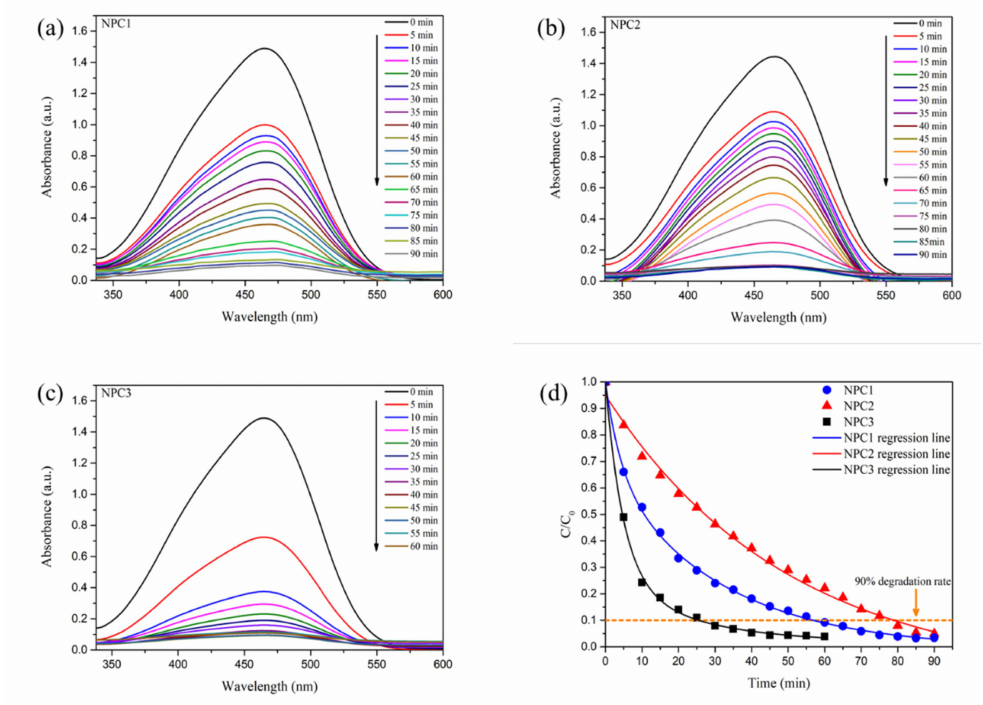
Figure 3. UV-Vis absorption spectra of degradation process toward MO solution by three different catalysts ( a – c ) and their relative degradation rate ( d